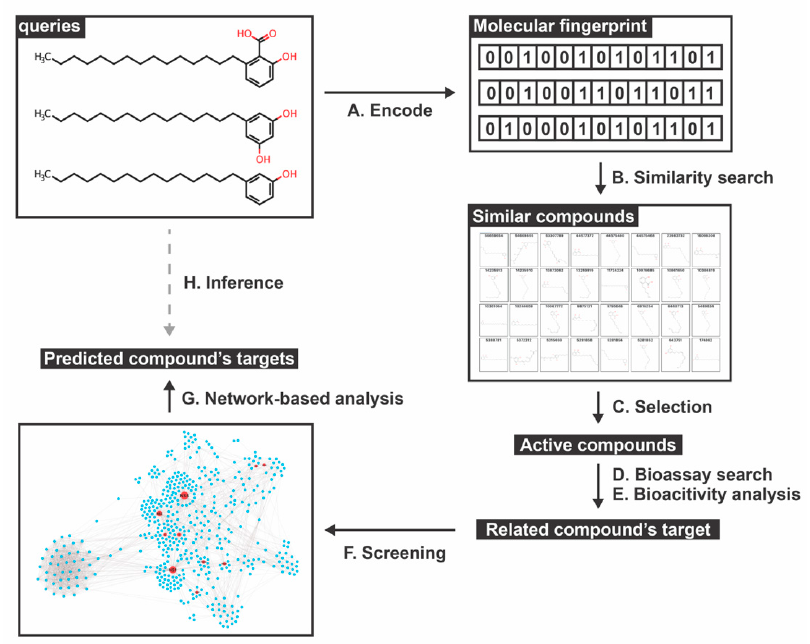
Figure 1. Schematic framework of this study. (A,B) Active compounds are translated into a molecular fingerprint format (binary code) as a template for the similarity search of the database based on a similar coe ffi cient. (C–E) Among similar compounds, only the active molecules are chosen and searched for their targets using the Bioassay and Bioactivity databases. (F,G) The related compound’s targets are screened by the DENV-human interactome network (DenvInt) [41] and scored using the network-based analysis method. Finally, (H) the DENV-host related targets of active similar compounds are annotated and identified for their potential function using several